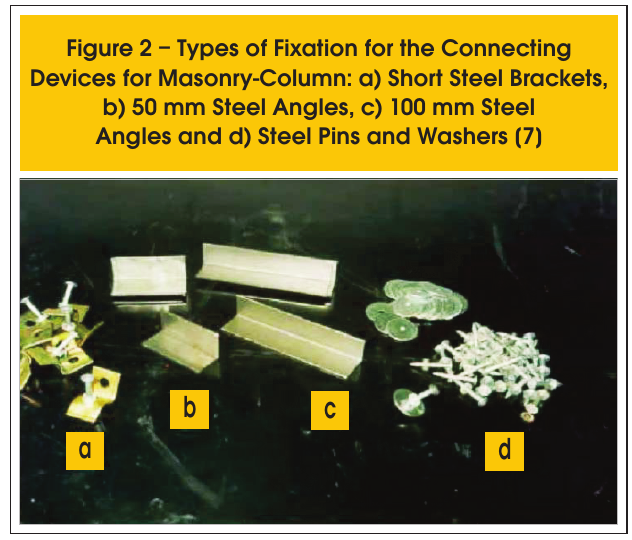
Figure 2 – Types of Fixation for the Connecting Devices for Masonry-Column: a) Short Steel Brackets,